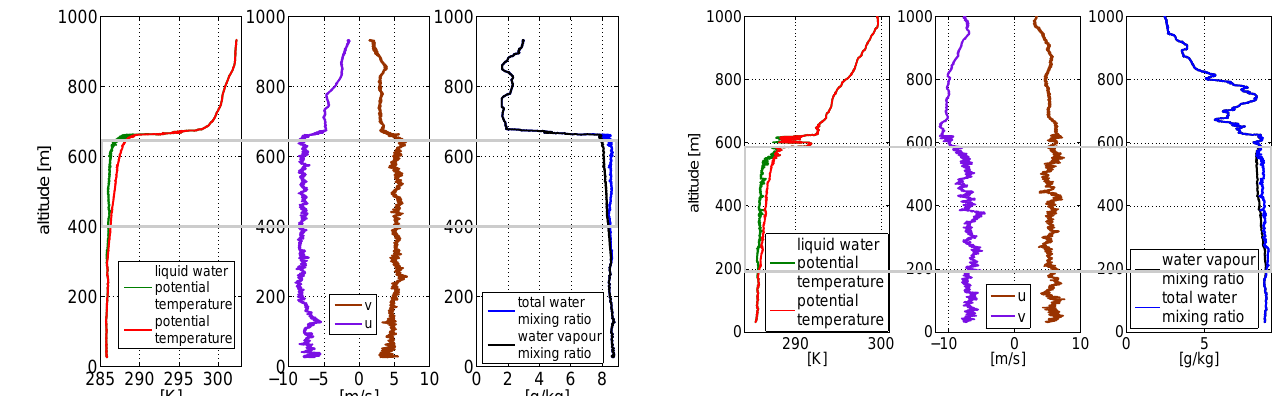
Fig. 3. As in Fig. 2 but for flight Fig. 2. Vertical profiles of potential temperatures, components of Fig. 3. As in Fig. 2, but for flight TO13. horizontal wind, and mixing ratios characteristic for research flight Fig. 2. Vertical profiles of potential temperatures, components of horizontal wind, and mixing ratios TO10. Cloud layer marked with a gray box. characteristic for research flight TO10. Cloud layer marked with a gray box.